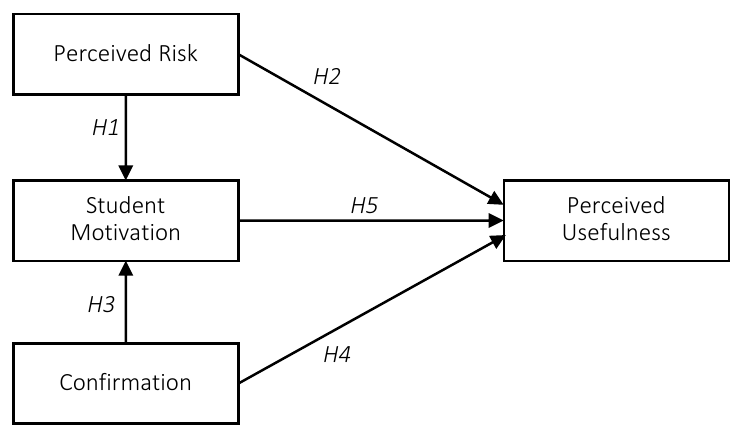
Figure 1. Conceptual